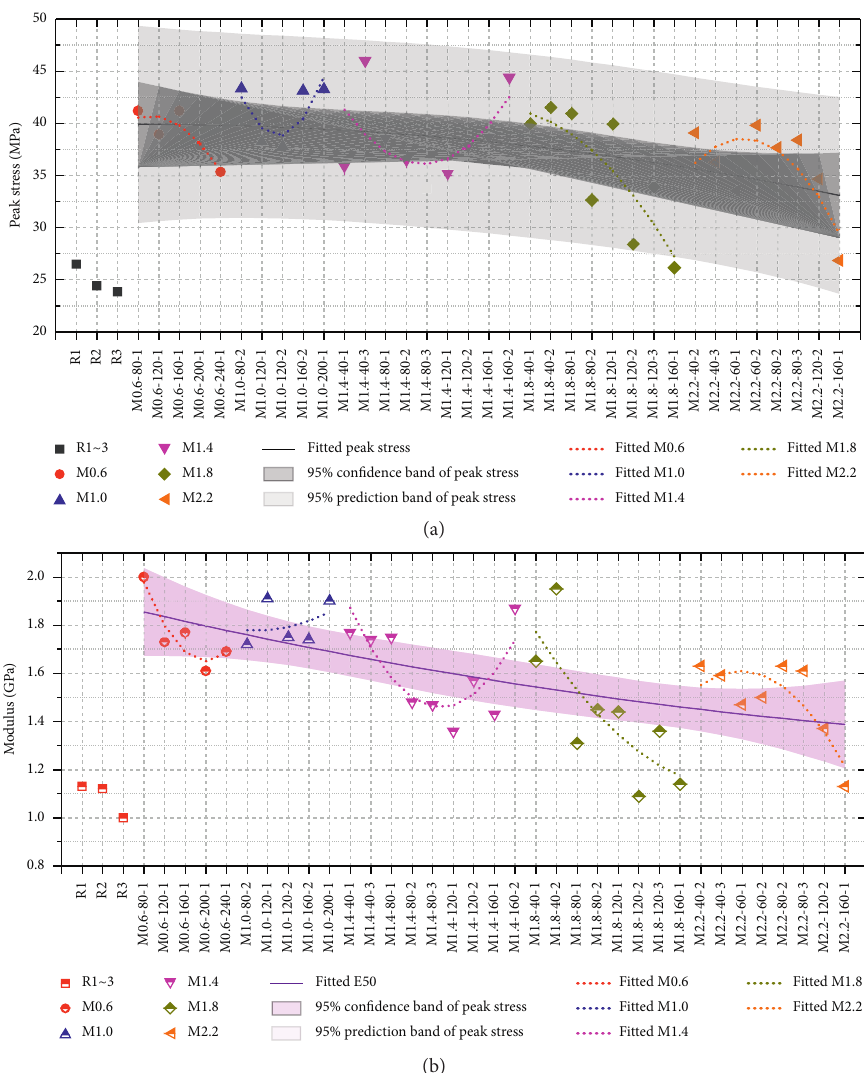
Figure 7: Collection of peak stress and secant modulus (E50) data of all valid specimens: (a) peak stress; (b) secant modulus